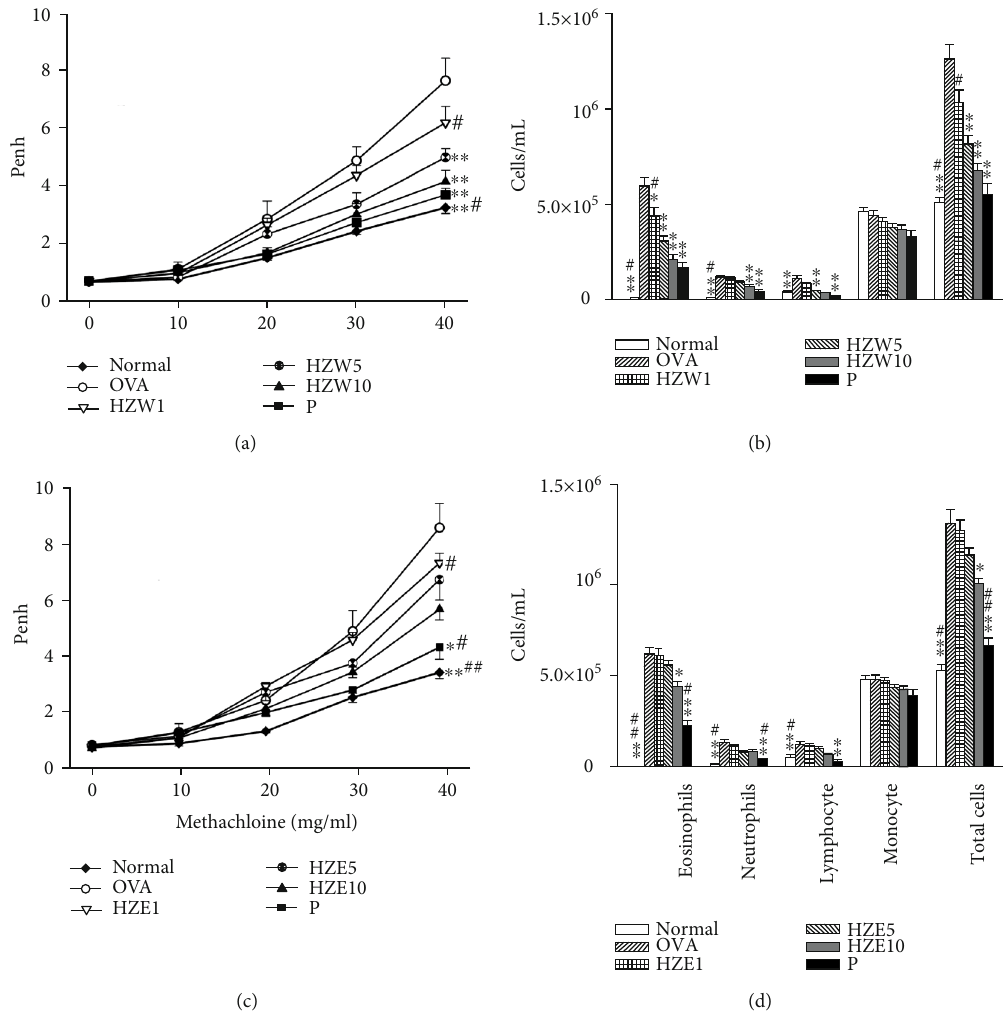
Figure 4: E ff ect of HZW or HZE on AHR and cell counts in the BALF of asthmatic mice. The AHR (Penh values) was measured after inhalation of increasing methacholine doses (10-40mg/ml) in normal (N) and OVA-stimulated (OVA) mice, treated with or without HZW (a) or HZE (c) ( n = 10 mice/group, measured in three independent experiments). The numbers of in fl ammatory cells and total cells in the BALF from OVA-sensitive mice, treated with or without HZW (b) or HZE (d). All data are presented as the mean ± SEM . ∗ P < 0 : 05 and ∗∗ P < 0 : 01 compared with the OVA control group. # P < 0 : 05 and ## P < 0 : 01 compared to the HZW10 or HZE10 group. Prednisolone (P) control orally administered with 5mg/kg prednisolone as positive